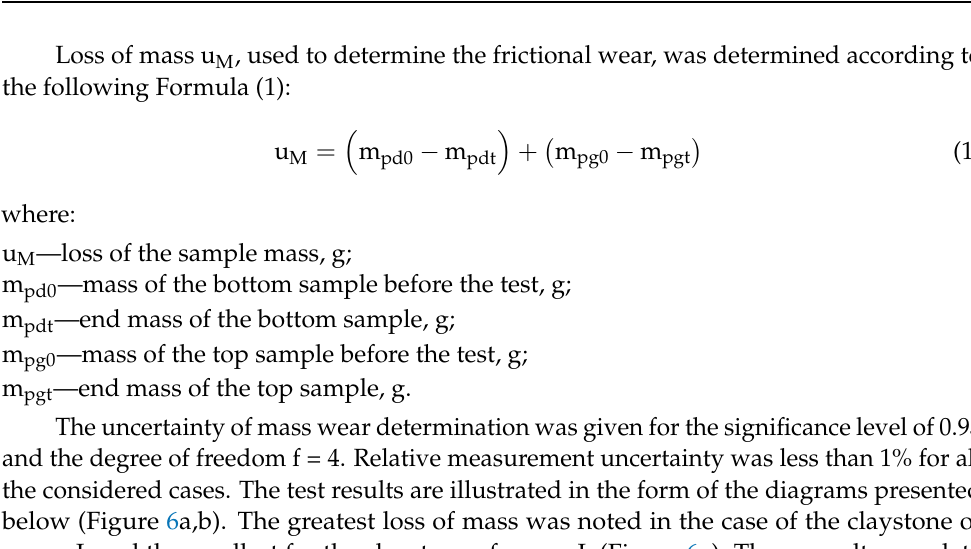
Figure 5. Ring samples.